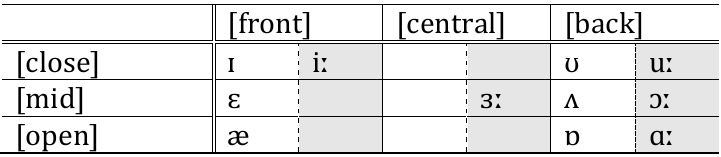
Table 8: The monophthongs of Modern English.